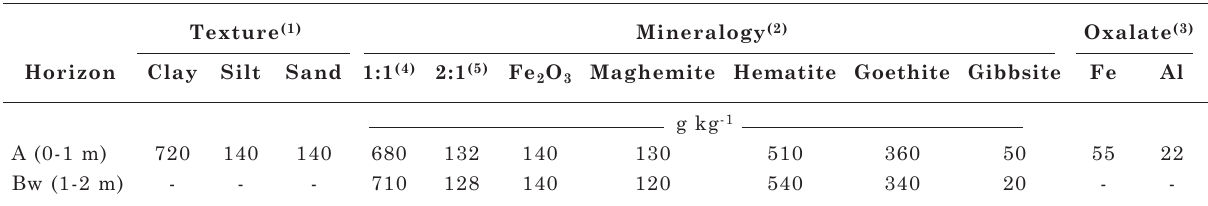
table 1. texture and mineralogy of a rhodic hapludox, in an experimental area after 23 years of different soil managements and winter